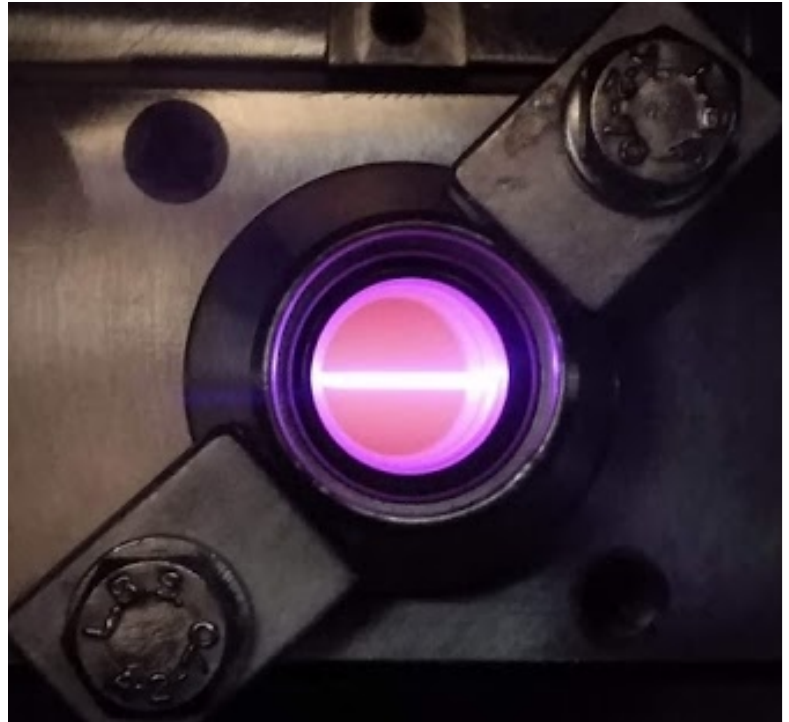
Figure 1. Nitrogen plasma glow in the gas filter chamber of the DESIRS beam line with the synchrotron pencil beam